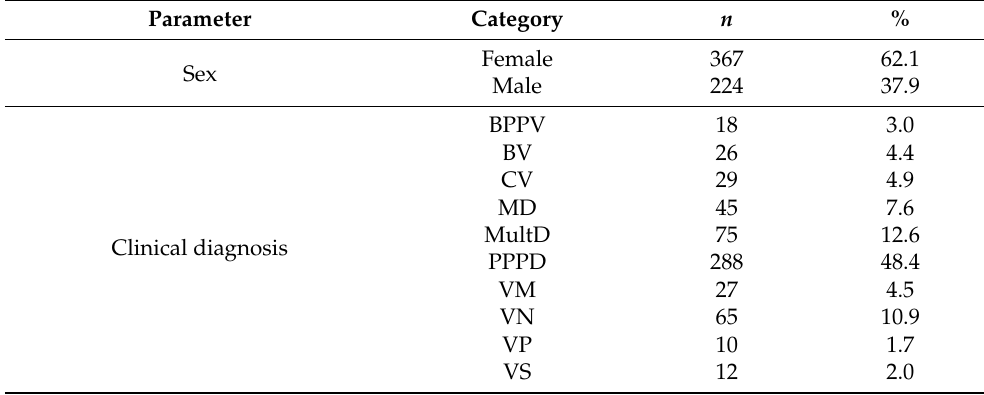
Table 1. Descriptive statistics